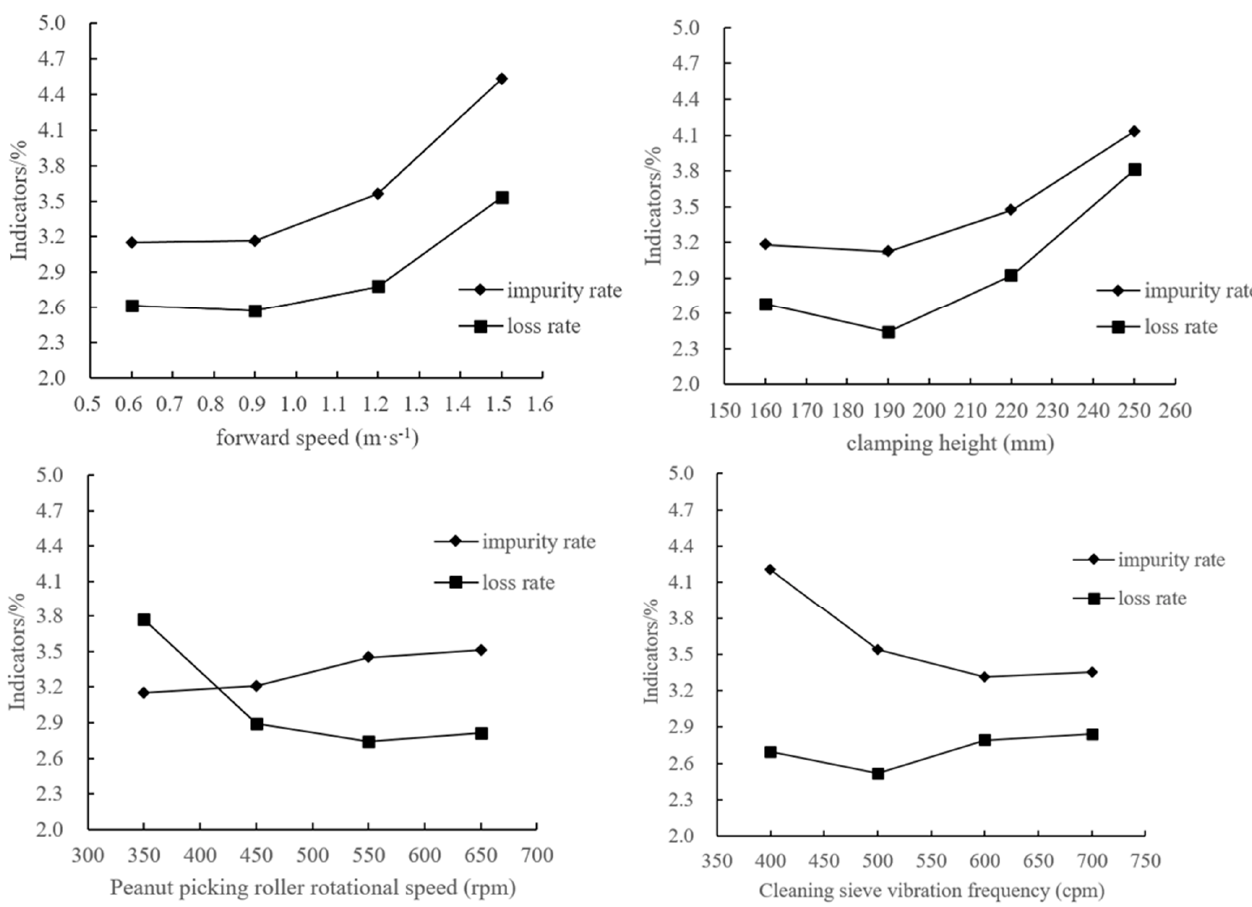
Figure 8. Effects of various test factors on the impurity and loss rates. Table 1. Experimental factors and their levels.